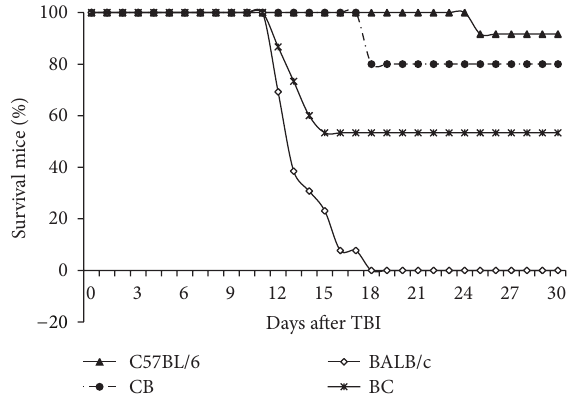
Figure 1: Effect of radiation on survival (LD 50/30 ) in 4 mouse strains. In groups of 7 ∼ 13, mice were exposed to 7 Gy TBI from a cesium- 137 gamma source. Mouse survival and death rates were recorded. Significant differences existed between the C57BL/6 and BALB/c strains; survival in the F1 hybrids was significantly increased as compared to the BALB/c